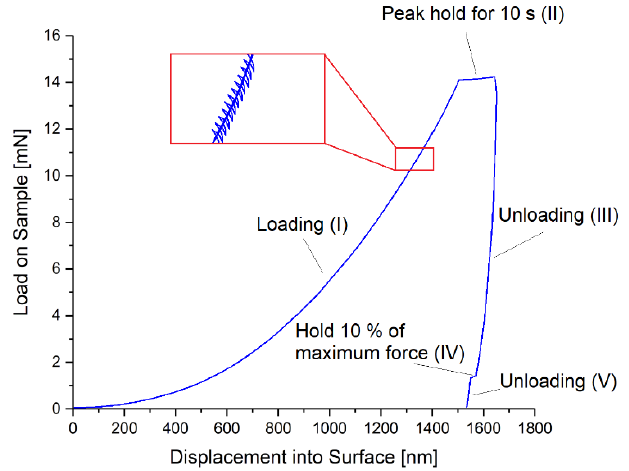
Figure 4. Applied load cycle for the nano-indentation measurements consisting of five parts: (I) increasing the load, (II) holding the maximum force, (III) decreasing the load until 10% of maximum force, (IV) holding 10% of the maximum force for 75 s, and (V) decreasing the load until zero.